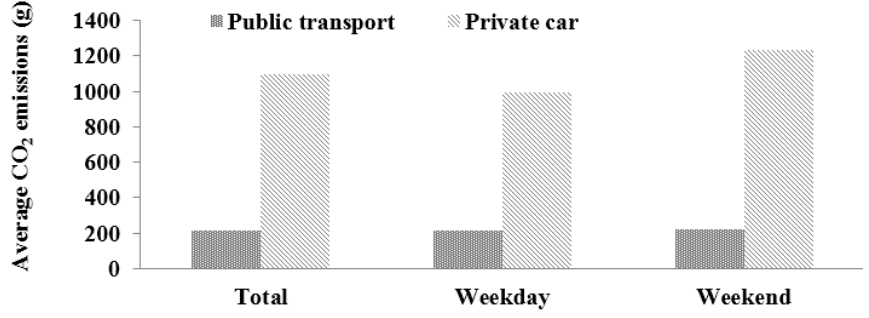
Figure 4. Average CO 2 emissions between different travel modes.